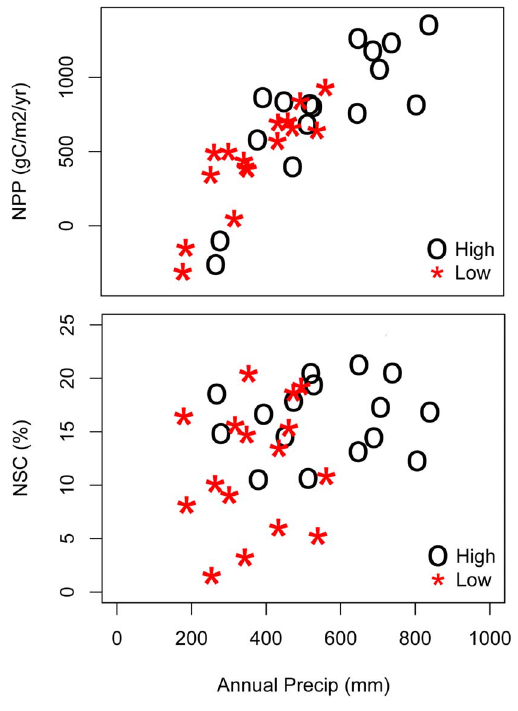
Figure 10. NPP and NSC against precipitation for high and low elevation sites over 1992-2007 simulation